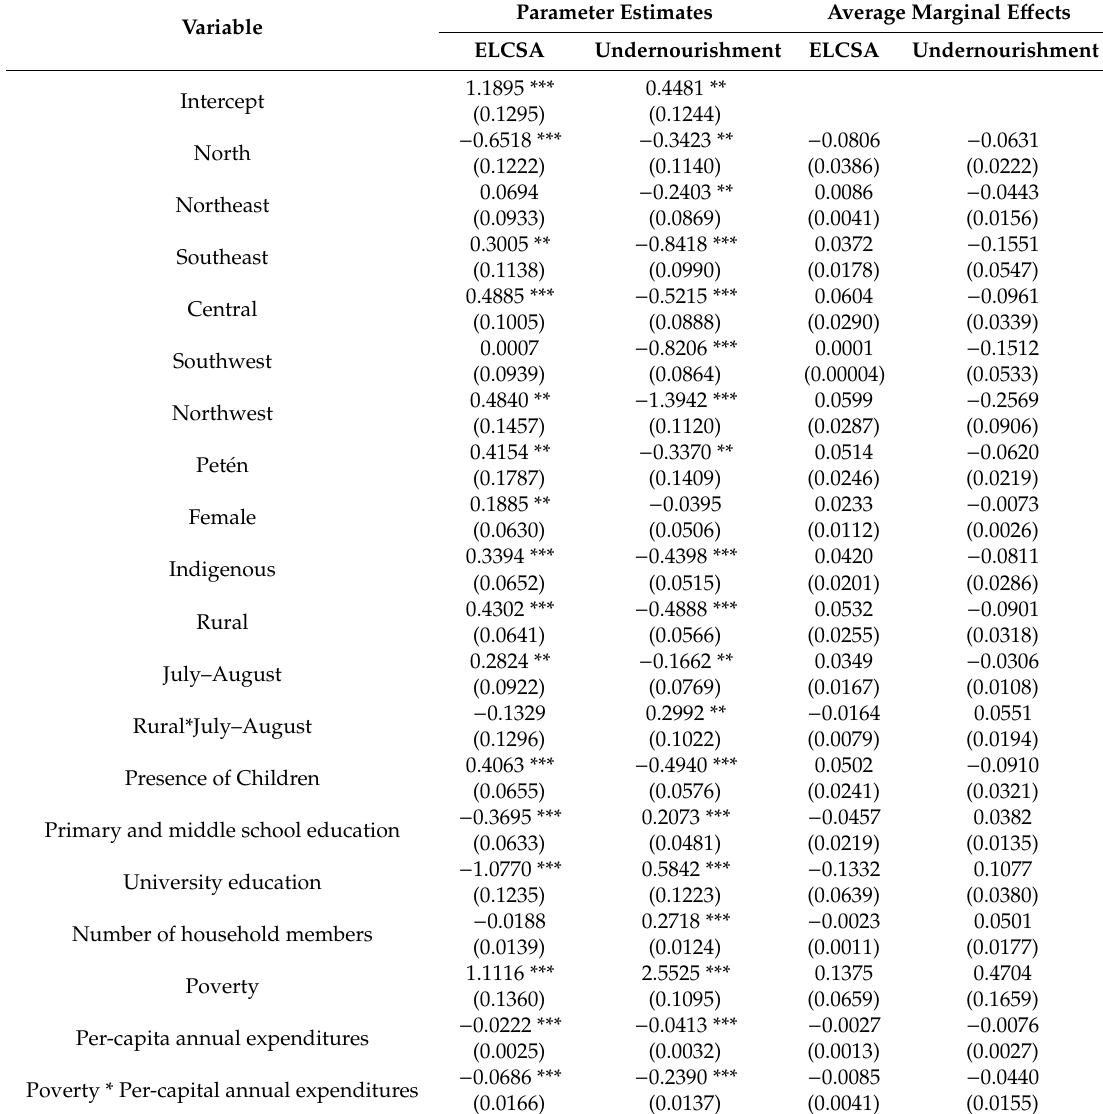
Table 4. Parameter estimates of logistic models for the food insecurity status of households using data representative of the entire